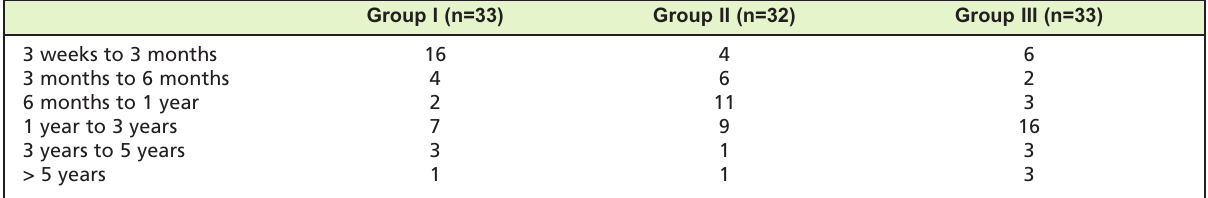
Duration of injury before surgery Table III: